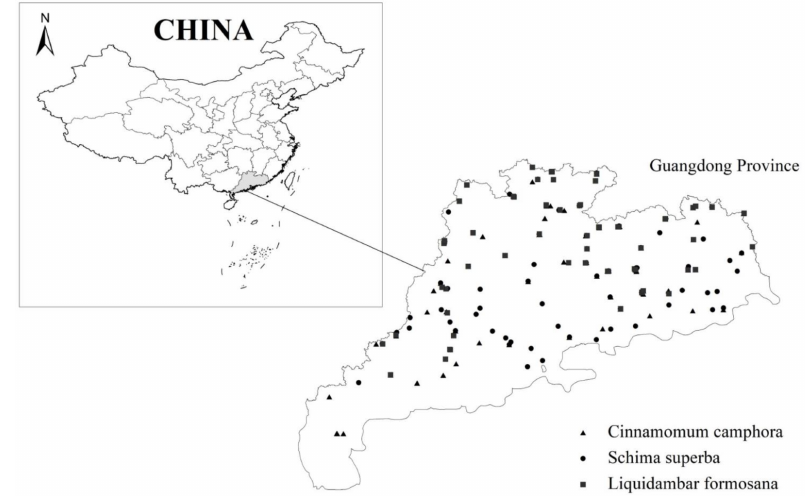
Figure 1. The locations of trees for three broad-leaved tree species. Table 1. The descriptive statistics for 90 sampling trees of each broad-leaved tree species. Cinnamomum camphora (L.) Schima superba Gardn. et Liquidambar formosana Presl Champ. Variable